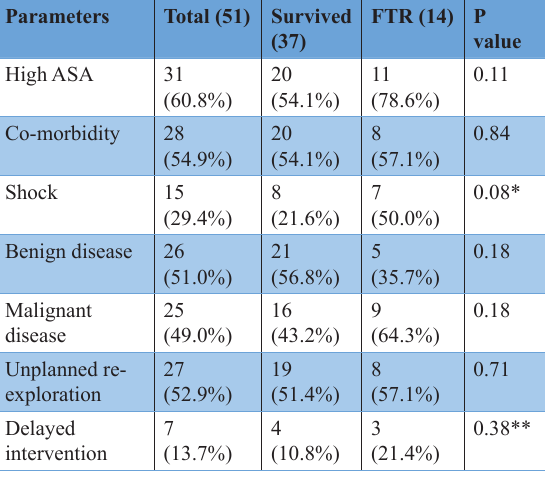
Table 2. Evaluation of risk factors of failure to rescue